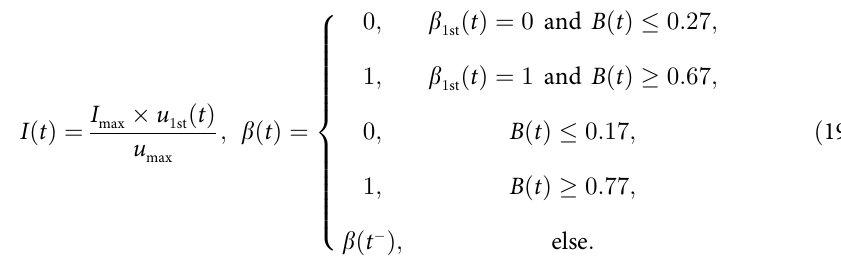
Fig 9. Periodic circadian and sleep homeostasis states in three models. The blue lines of x 3rd , x represent the periodic circadian and sleep homeostasis states of the S+C3 model, the red lines of x 2nd , x c 2nd , H 2nd , θ 2nd represent those of the S+C2 model, the black lines of θ 1st and H 1st represent the periodic circadian phase and sleep homeostasis of the S+C1 model.